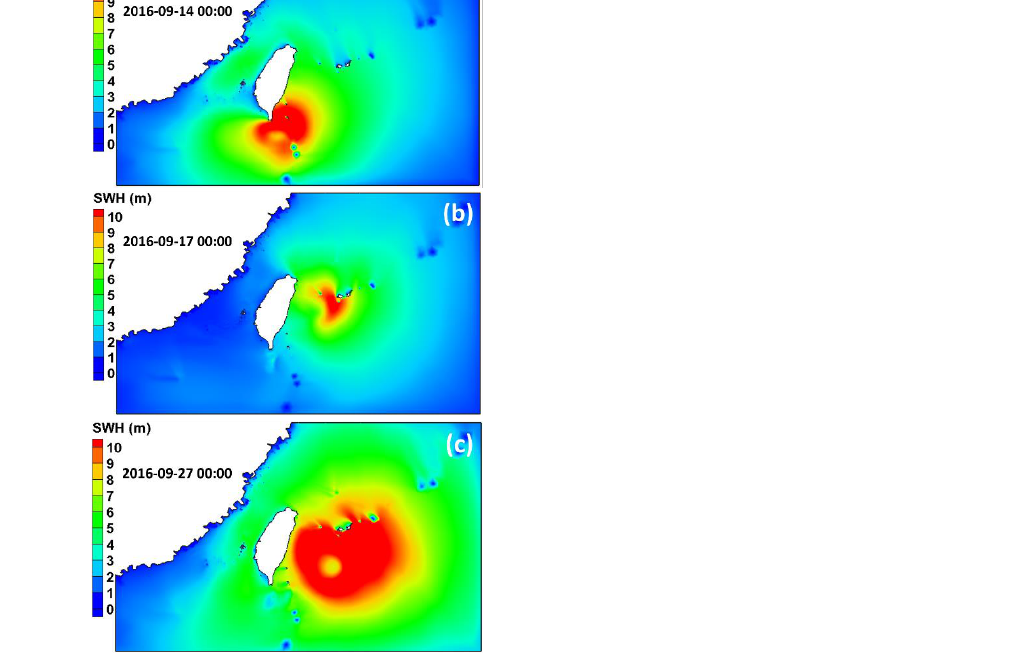
Figure 9. Spatial distribution of the simulated significant wave height at ( a ) 00:00 on 14 September 2016, ( b ) 00:00 on 17 September 2016, and ( c ) 00:00 on 27 September 2016, using the D02 computation domain and ERA5 wind fields.